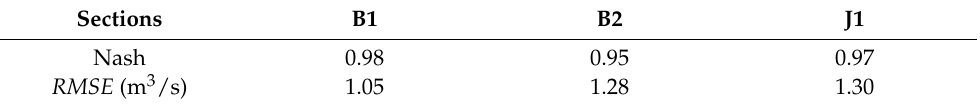
Figure 5. Verification of discharge estimation results from 2017 to 2019. B1, B2, and J1 correspond to the Wenquan Hydrological Station, Bole Hydrological station, and Jinghe Hydrological station, respectively. Table 5. Error analysis of the discharge estimation results of the cross-section at Hydrological station.